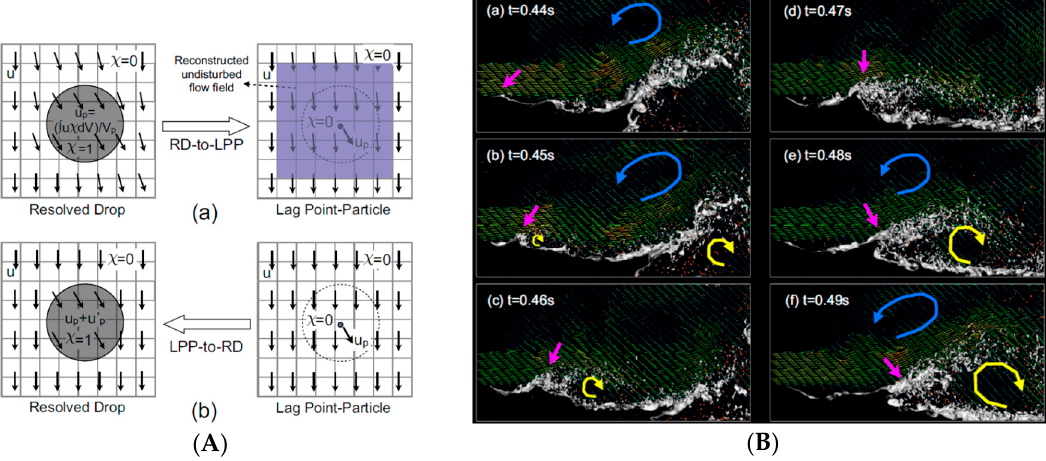
Figure 9. Result of the atomizing planar liquid jet with the hybrid DNS and Lagrangian method [56]. ( A ) Proposed numerical procedure ( a ) to convert a resolved droplet (RD) to a Lagrangian point particle (LPP) and ( b ) vice versa; ( B ) Example of a planar jet. The gray and orange colors indicate the resolved interface and the point-particle droplets, respectively. The red arrow indicates the position of a wave front where vigorous atomization (including RDs and LPPs) occurs as it develops. Reproduced with permission from Elsevier.